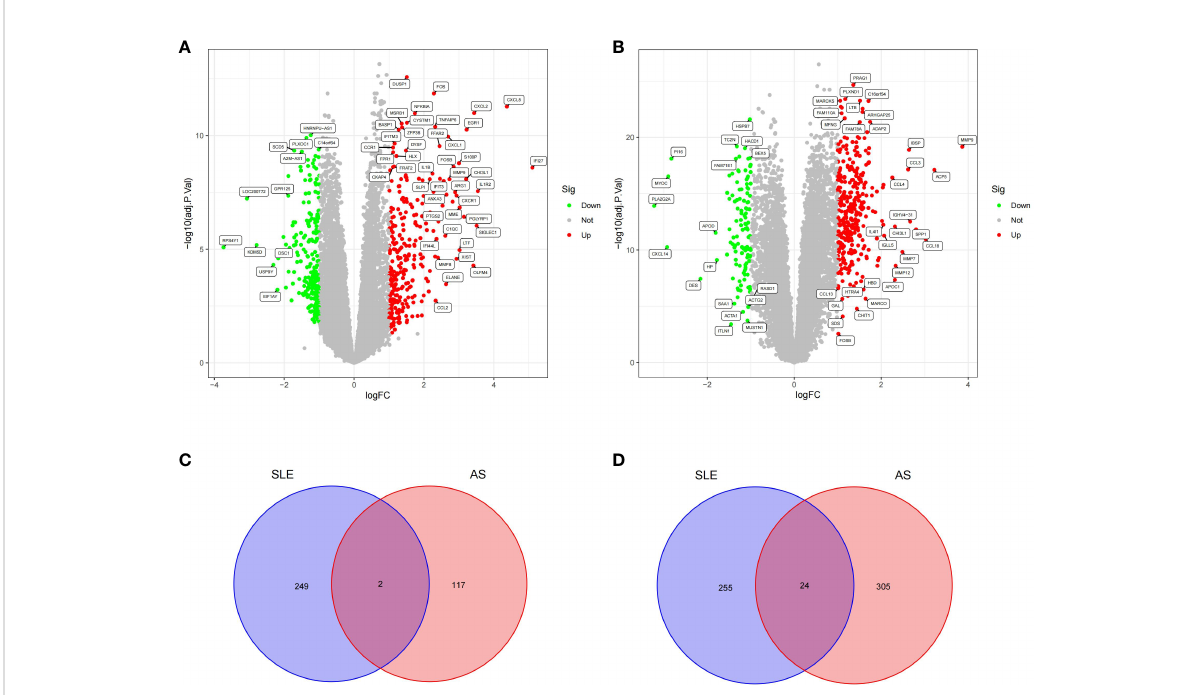
FIGURE 1 Volcano plot and Venn diagram. (A) Volcano plot of differentially expressed genes (DEGs) in GSE50772. (B) Volcano plot of differentially expressed genes (DEGs) in GSE100927.The up-regulated genes were marked with red, the down-regulated genes were marked with green, and the genes with no signi fi cant changes were marked with gray. (C) Venn diagram of down-regulated genes in GSE50772 and GSE100927. (D) Venn diagram of up-regulated genes in GSE50772 and